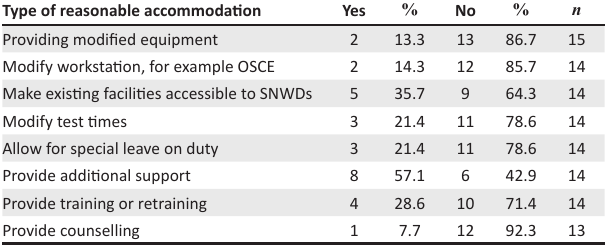
TABLE 2: Access to clinical sites.